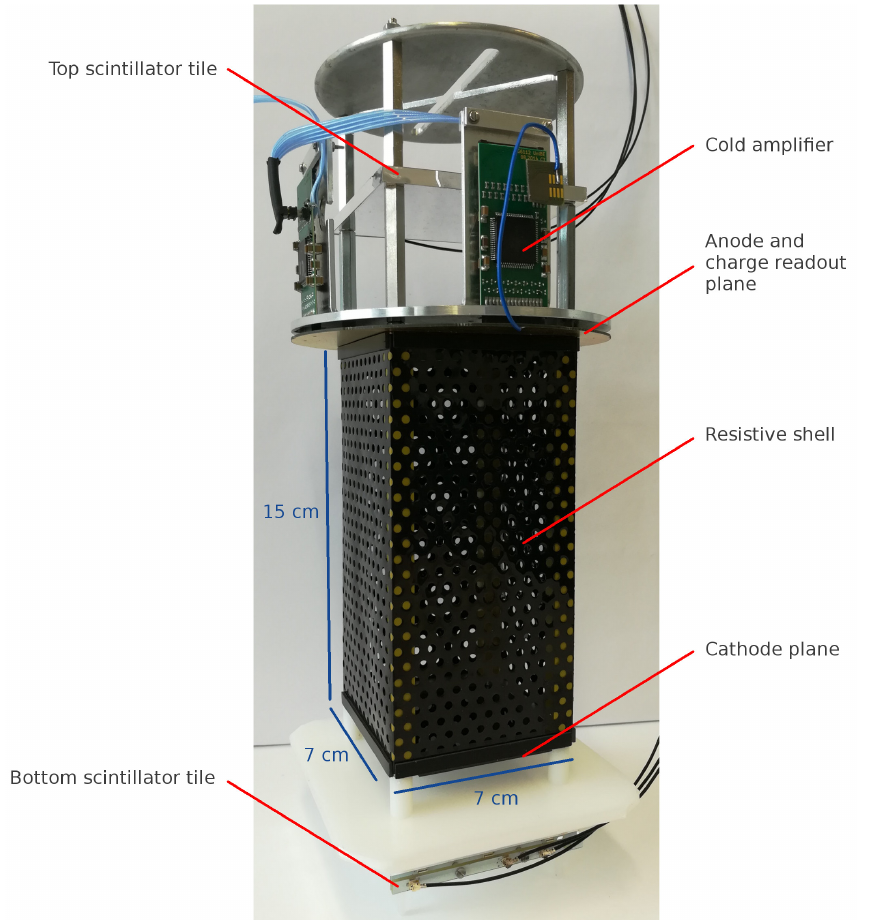
Figure 2. Prototype of the resistive shell TPC used for the measurements. The holes in the shell foil assure an adequate flow of purified LAr from outside into the TPC drift